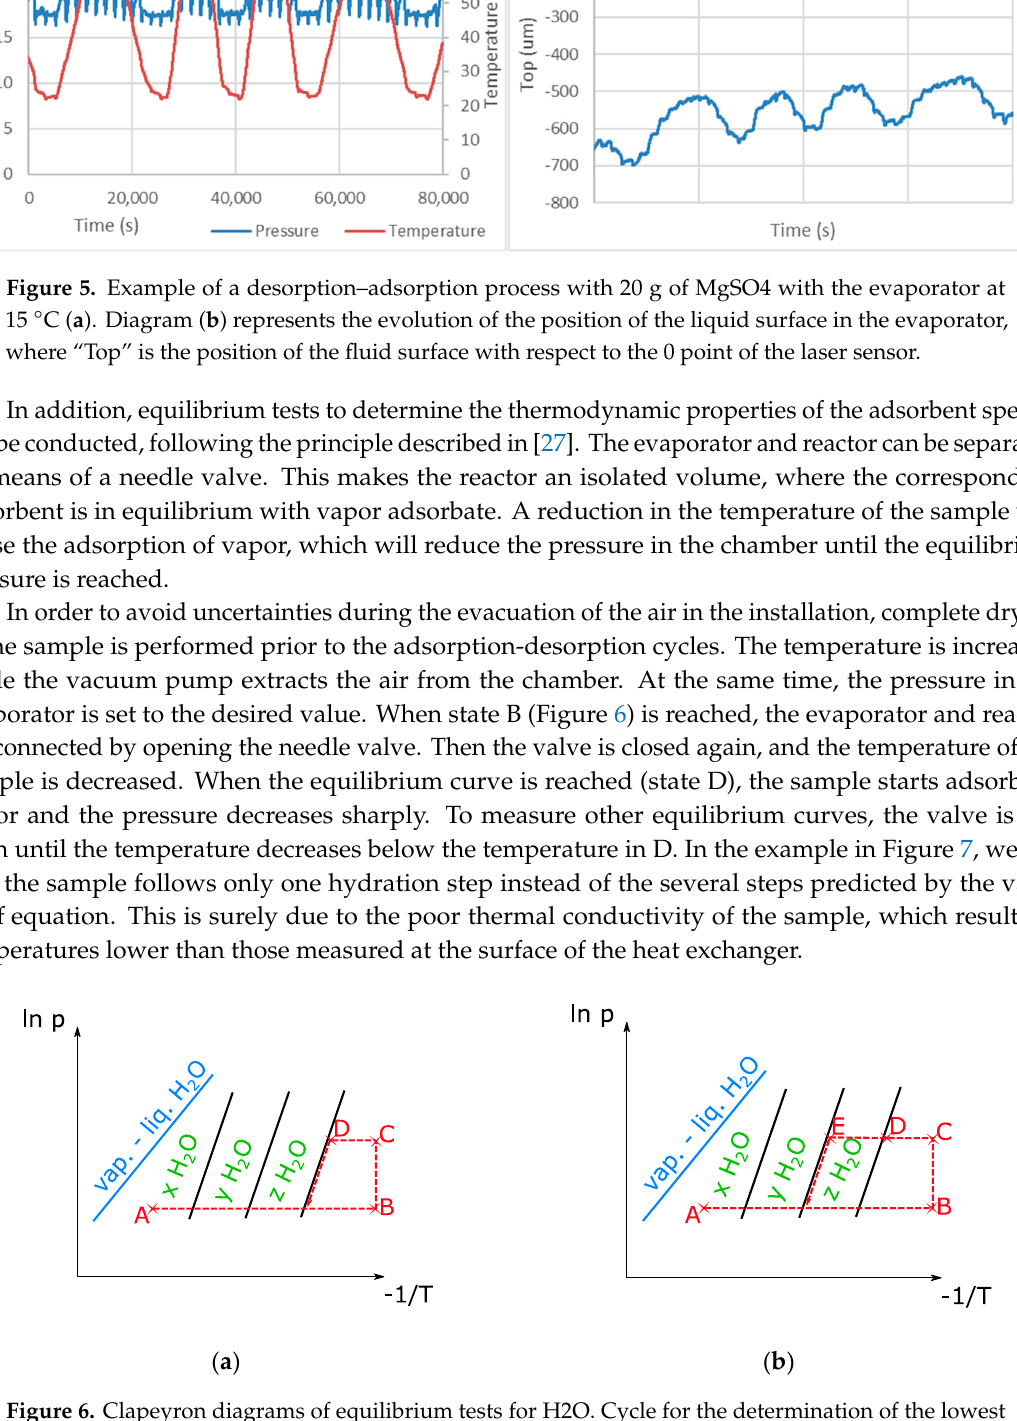
( b ) Figure 7. Example of a series of desorption-adsorption cycles with MgSO4 ( a ), compared with the van’t Hoff equation with data from Donkers et al. [28] ( b ). 4. Overview and Conclusions In order to reduce costs, the installation was designed employing as many normed parts as possible. The concept, however, is very versatile and can be adapted to other specifications. Smaller amounts of adsorbate can be surely detected with a narrower evaporator. The installation could also be adapted to higher adsorption rates, while maintaining the same tolerances for the deviation from equilibrium, at the cost of reducing its pressure rating. The laser sensor is capable of measuring displacements of the liquid surface as small as 0.01 µm, which corresponds to a sensibility below 1 mg of water with the dimensions employed in this work. Increasing the number of customized parts, this sensibility could be reduced, mainly by reducing the diameter and the thickness of the sight glass. Optical sensors with higher sensibility could be used, and the displacement per unit of evaporated/condensed volume would be increased. We conclude that optical sensors allow higher sensitivity than other traditional alternatives (with the exception of spectroscopic installations)—e.g., if the sensor was to be substituted by a differential pressure transmitter, this should have a sensibility of around 10 − 4 Pa. The design presented in this article constitutes a simple and cost-effective concept that will allow the characterization of adsorption materials with higher accuracy. Adsorber developers will profit from this design, facilitating the creation of new technologies and the expansion of the market of adsorption refrigeration systems, heat pumps, and energy storage systems.